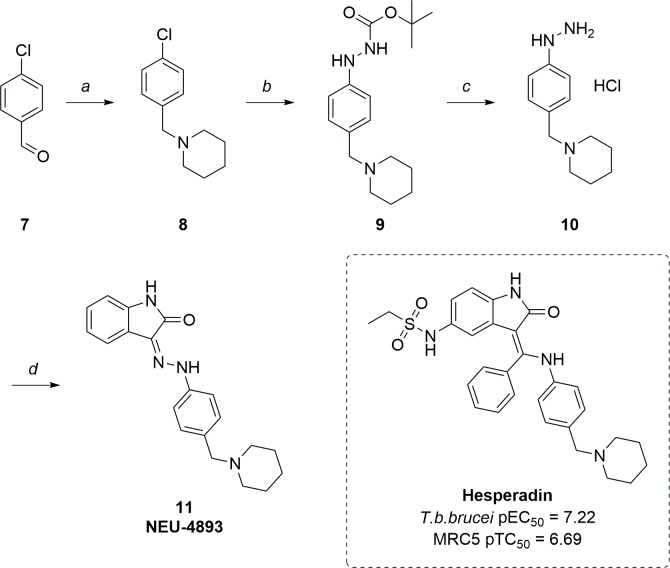
T. b. brucei activity of hesperadin and synthetic scheme for synthesis of NEU-4893.Reagents and reaction conditions: a) Piperidine, TEA, AcOH, NaHB(OAc)3, DCM; RT, 12 h (85%). b) Boc-NH-NH2, NaOtBu, Pd2(dba)3, XPhos, dioxane; μw, 150°C, 2 h (74%). c) 4M HCl in dioxane; RT, 3 h (74%). d) NaOtBu, isatin, MeOH; RT-50°C, 48 h (28%).